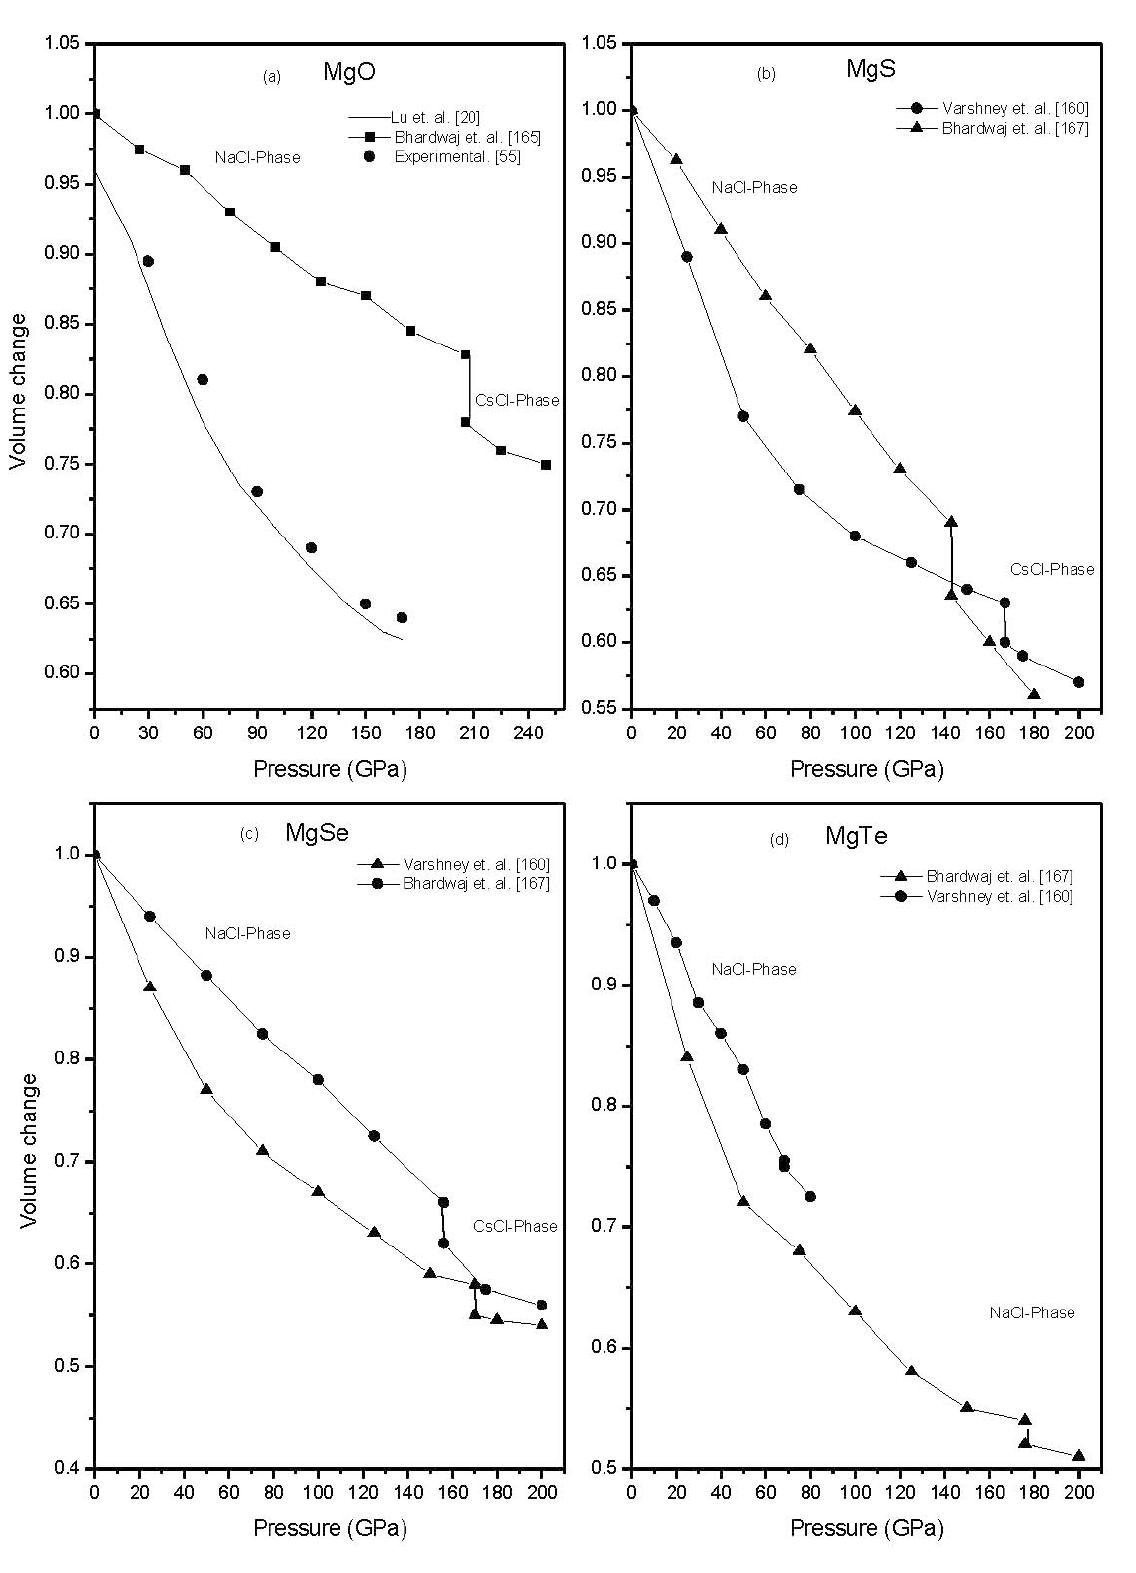
Figure 7. Variation of volume collapse with pressure for magnesium